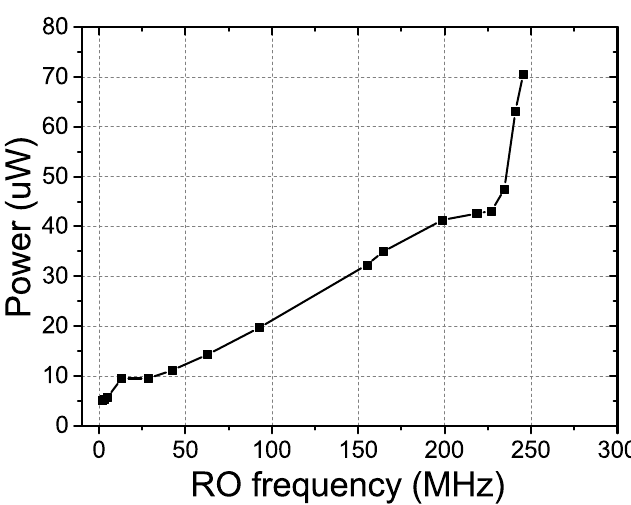
Figure 9. The measured average power consumption per challenge-response pair (CRP) of the proposed PUF at different ROs